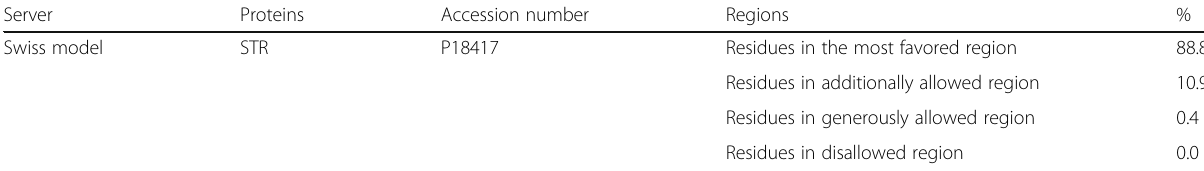
Table 6 Ramachandran plot calculation and analysis of the models from Swiss model and computed with the PROCHECK program Server